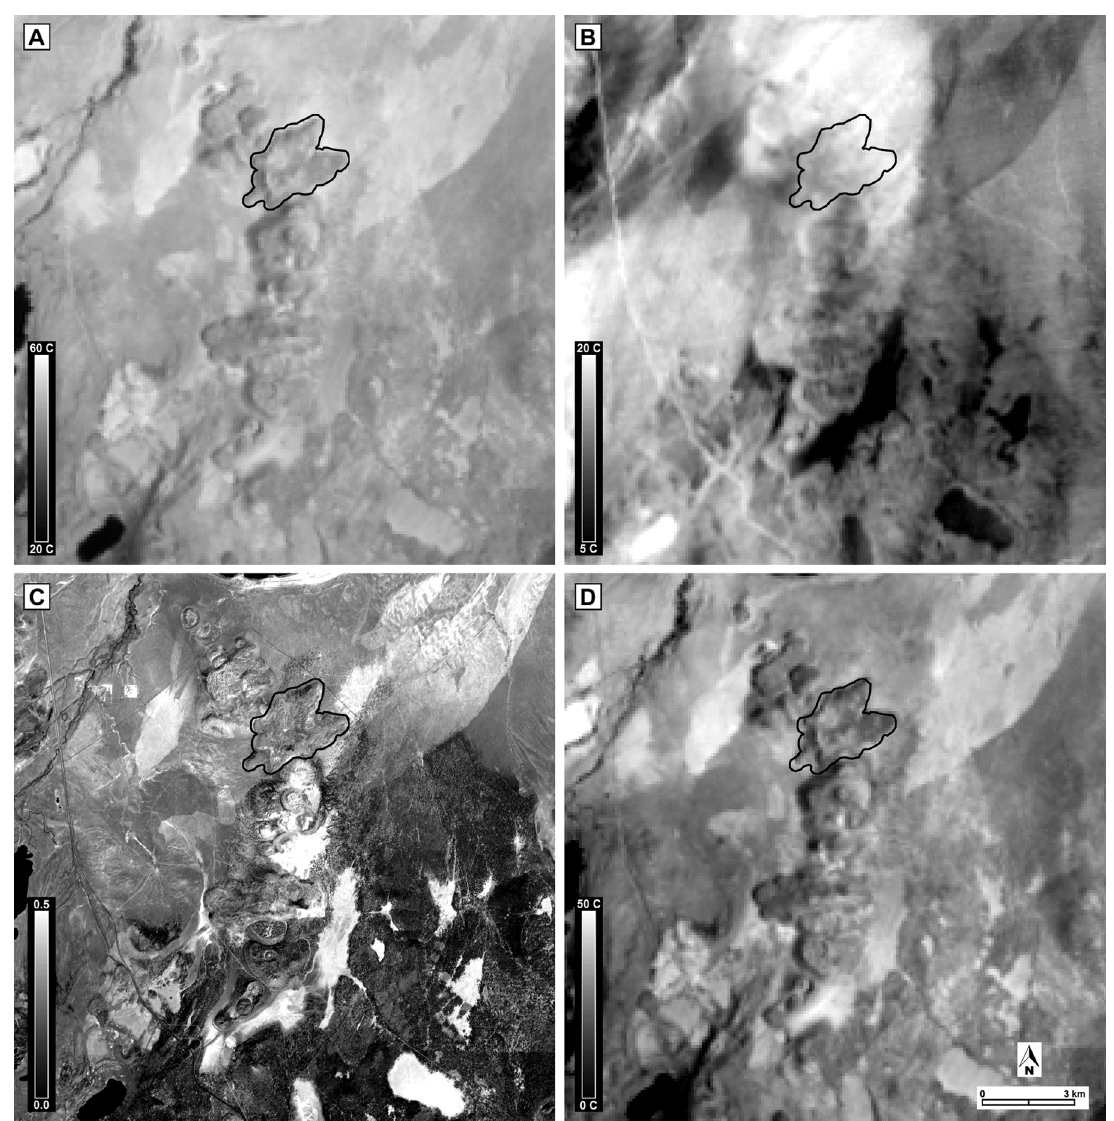
Figure 4. ASTER data products used to compile the apparent thermal inertia image. ( A ) Atmospherically-corrected, daytime surface kinetic temperature (ASTER level 2 AST_08 product) acquired on 10 July 2011 at 11:50:47 PDT; ( B ) Atmospherically-corrected nighttime surface kinetic temperature (ASTER level 2 AST_08 product) acquired on 10 July 2011 at 22:54:33 PDT; ( C ) Visible/Near Infrared surface albedo acquired at the same time as ( A ); ( D ) Temperature difference product (day − night).